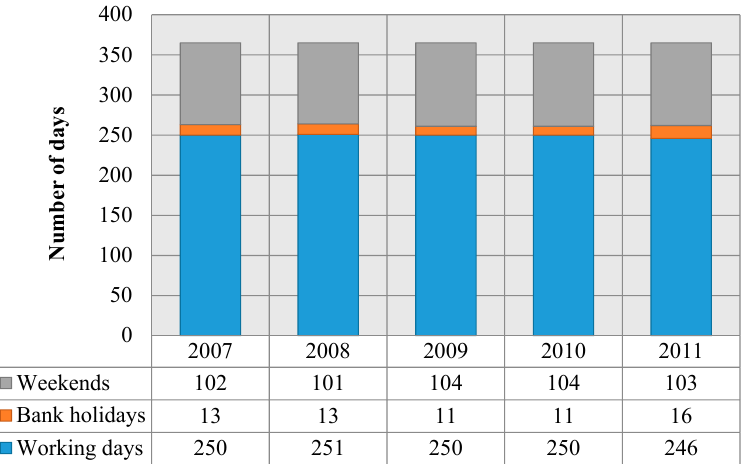
Figure 8. Variation in annual working and non-working days [36].